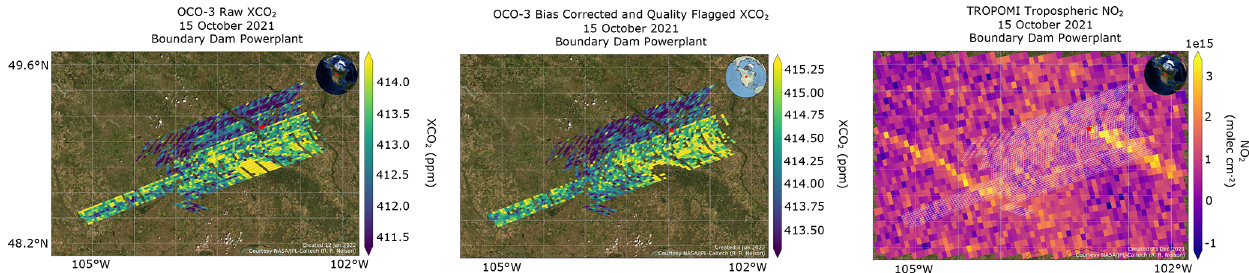
Figure 22. A v10 OCO-3 SAM whose SB flag is triggered by a real across-swath X CO on one side of the SAM, rather than a geometry-related bias.